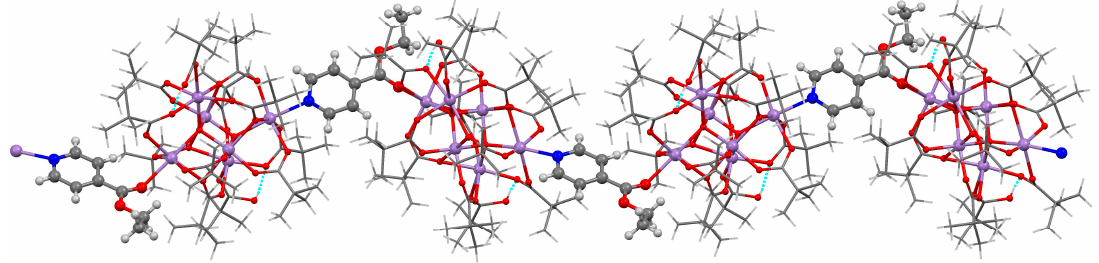
Figure 6. View of a 1D coordination polymer in 6 . The bridging ethyl nicotinate molecules are shown by bigger radii balls.